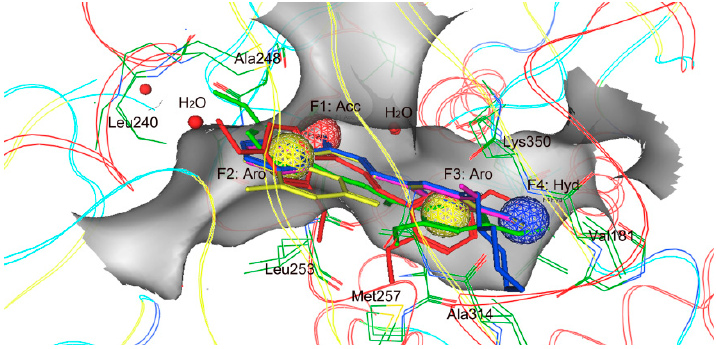
Figure 3. Pharmacophore mapping of five hits on model. Pharmacophore features are color-coded: Red, one hydrogen-bond acceptor feature (F1: Acc); yellow, aromatic features (F2 and F3: Aro); blue, one hydrophobic feature (F4: Hyd). The hits are shown in stick form; protein backbone and active site residues (green) are shown in line form; red balls mean water molecules; a gray pocket represents the shape of the binding site in tubulin. Table 3. Hit compounds selected from Specs database.